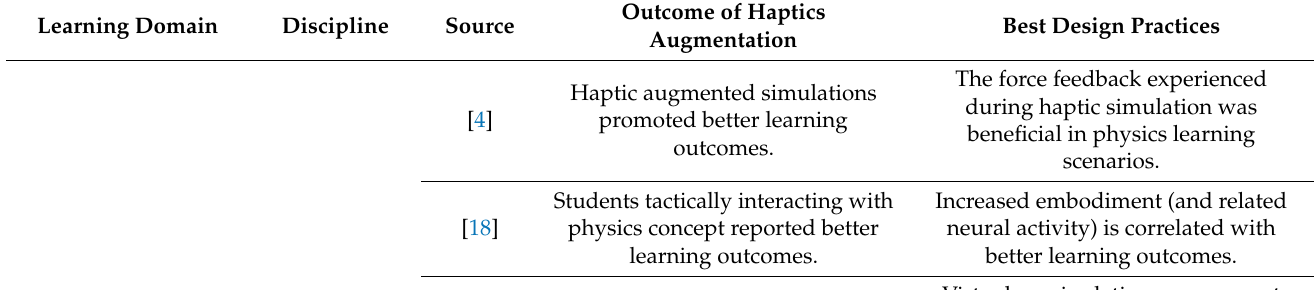
Table 2. Observation and best design practices based on learning domain and